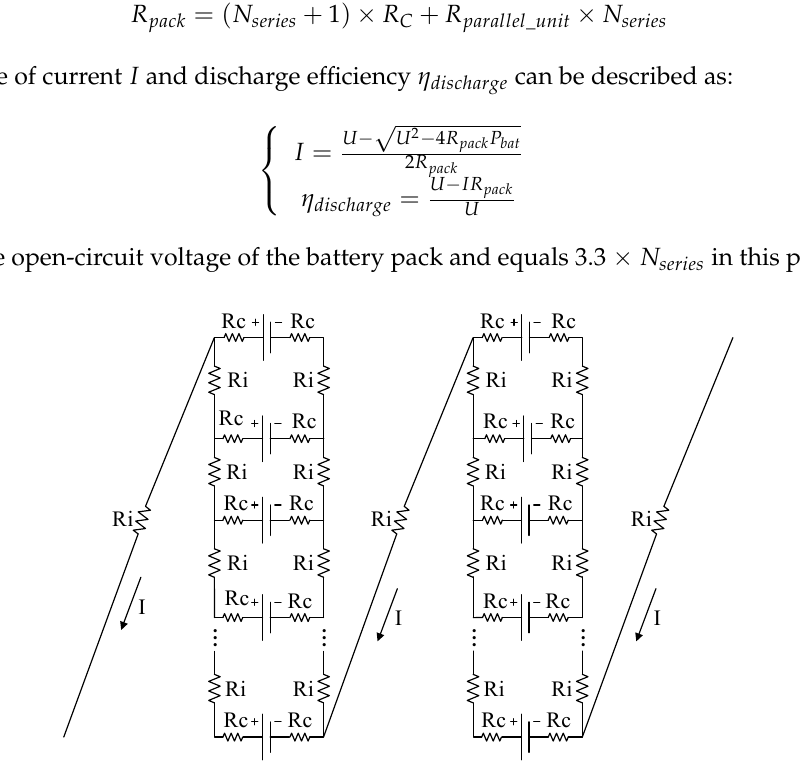
Figure 4. Schematic of series connection among each parallel unit.